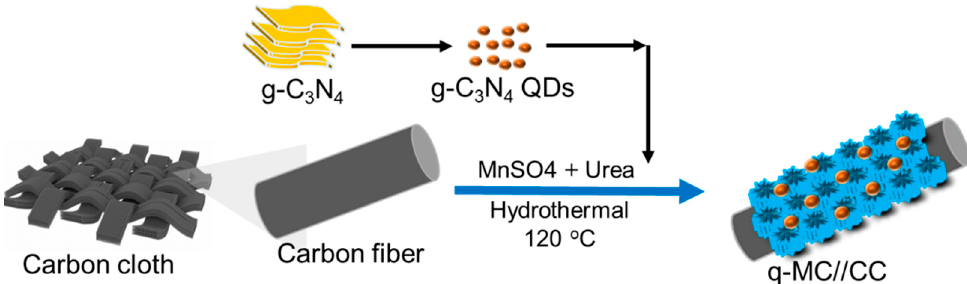
Figure 1. Scheme for the synthesis of g-C 3 N 4 quantum dots / manganese carbonates (MnCO 3 ) nanocomposite on carbon cloth.